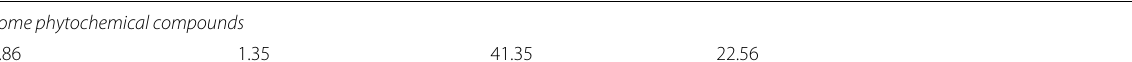
Measured macro-elements,